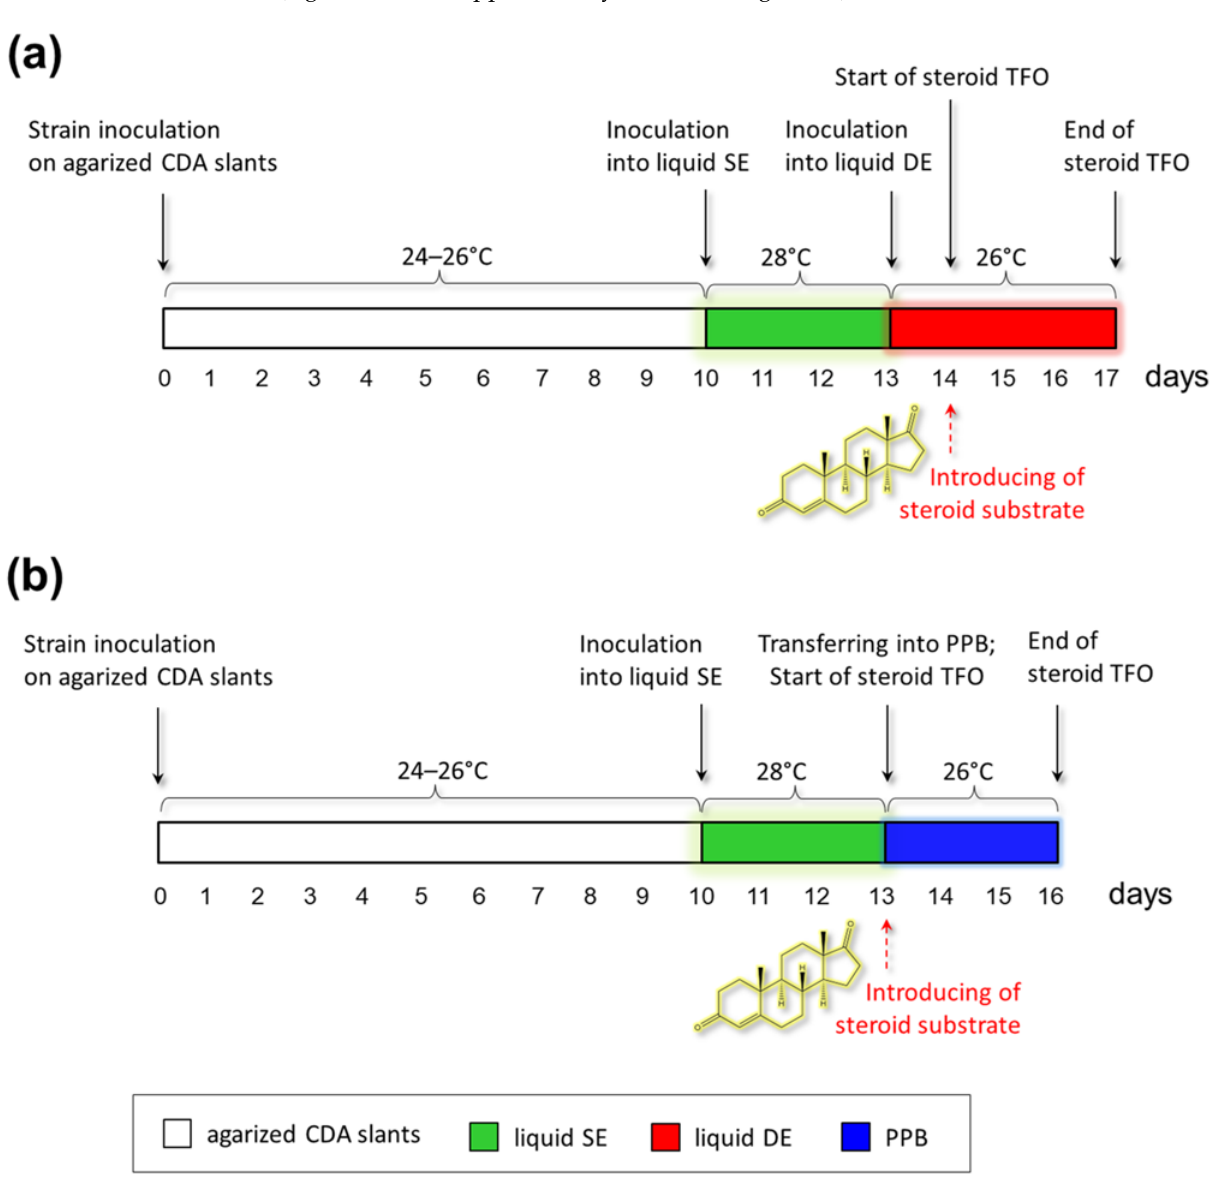
Figure 2. Timelines schemes of steroid conversion by fungi-destructors of tempera paintings: ( a ) steroid transformation into liquid defined (DE) medium; ( b ) steroid transformation into potassium phosphate buffer (PPB). CDA—Czapek-Dox agar medium; SE—liquid seed (SE) medium; TFO—transformation. The red dashed arrow shows the time of steroid substrate introduction. Table 1. GC/MS values and structures of steroid substrate and bioconversion products formed with filamentous fungi-destructors of tempera painting materials.